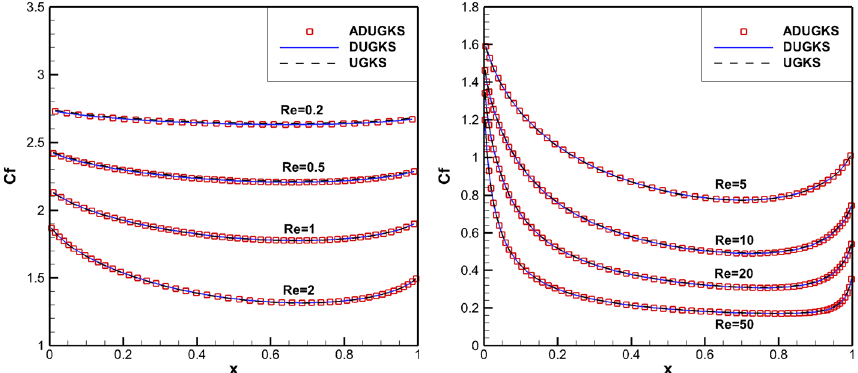
Fig. 7 Distribution of skin friction coefficient on the flat plate in the transition and slip flow